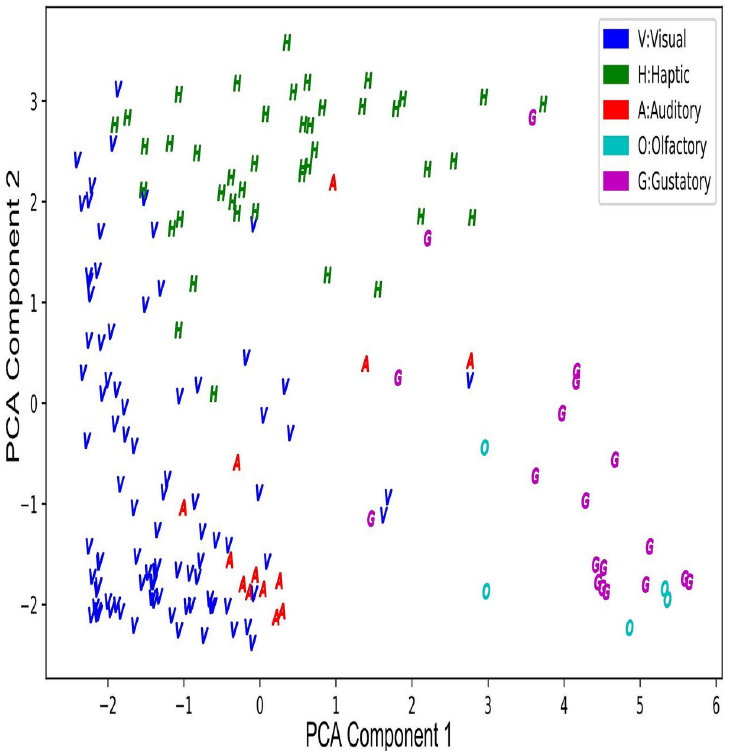
Fig 1. Relationship between clusters of monosyllabic words by dominant modality with relative strength on the five modalities reduced to two dimensions by principal component analysis.